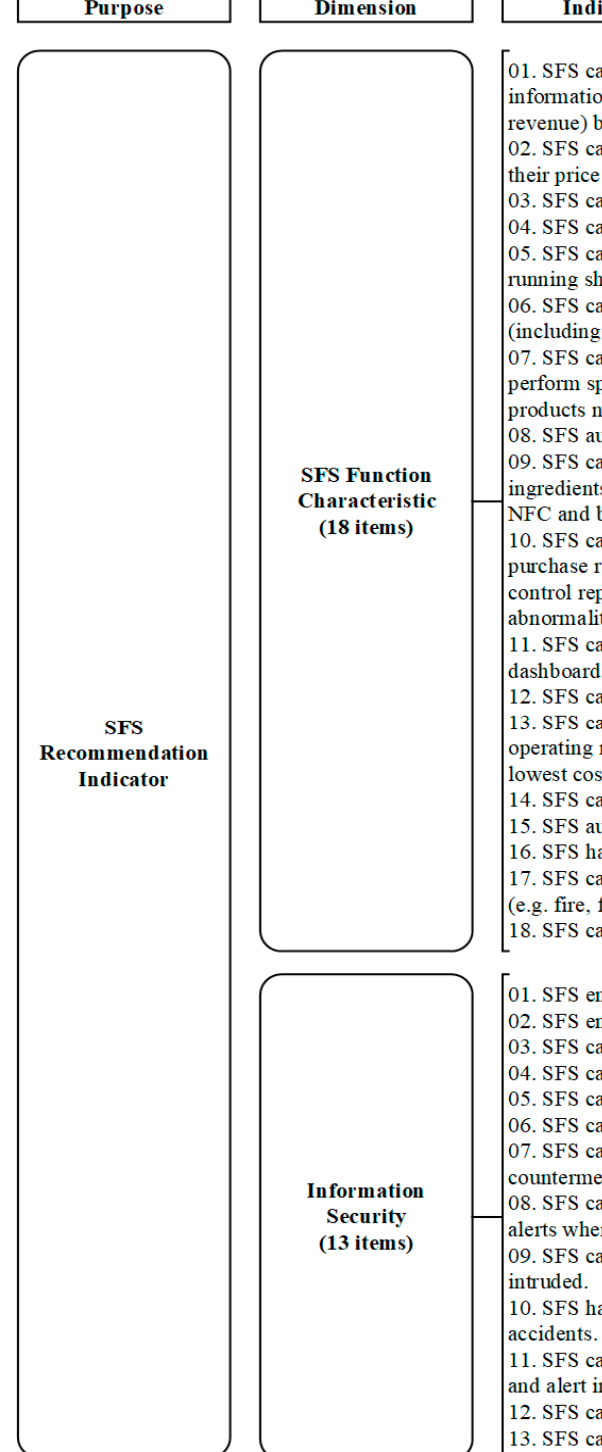
Figure 4. SFS recommendation indicators.